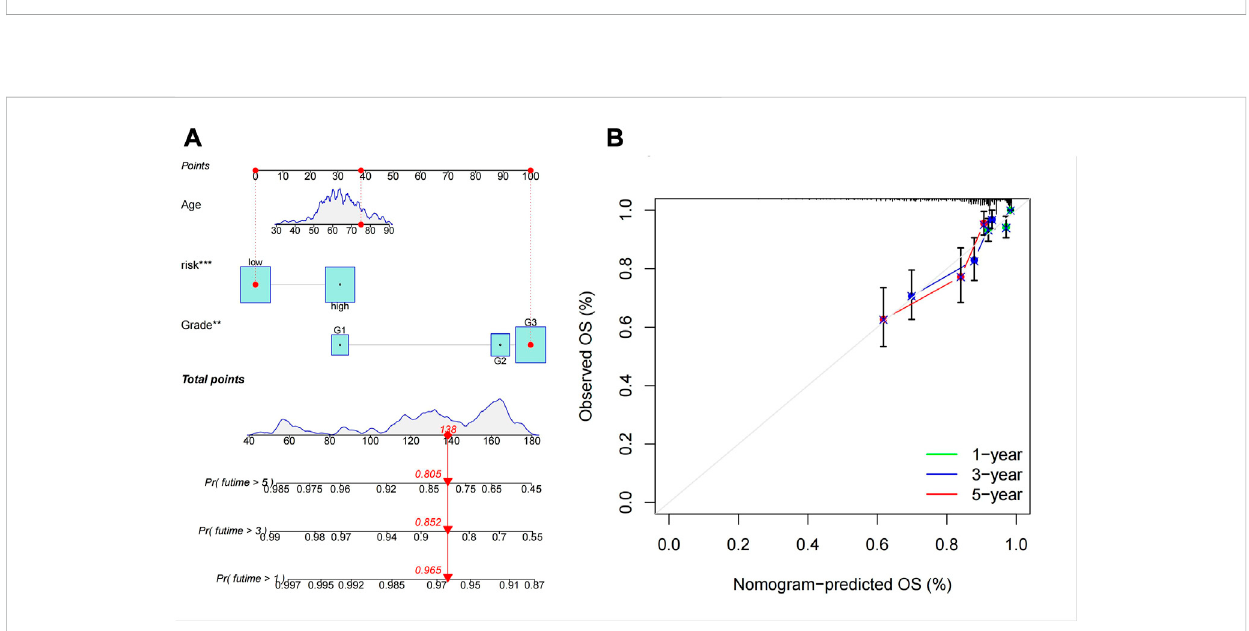
FIGURE 7 (A) Univariate regression analysis of the risk model and other clinical characteristics. (B) Multivariate regression analysis of the risk model and other clinical characteristics. (C) The ROC curve of the risk prediction model compared with other clinical factors. (D) The ROC curve of the risk prediction model at 1, 3, and 5 years.